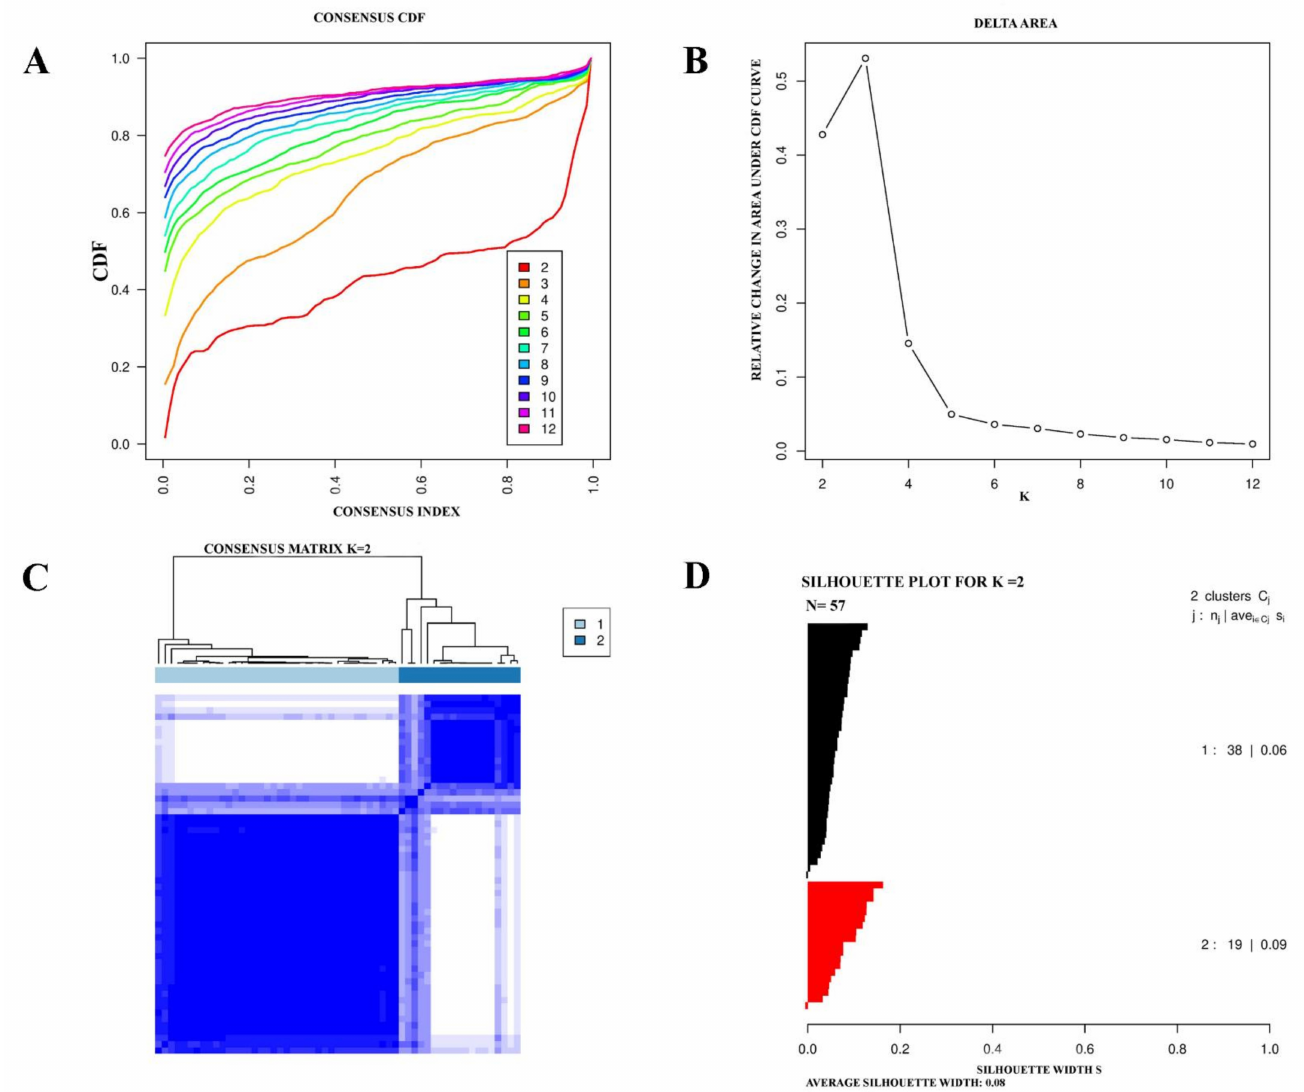
Figure 1. The TCGA cohort of eMPM, represented two molecular subtypes. ( A ) Using an empir- ical cumulative distribution plot, the optimal number of eMPM molecular subtypes was found. ( B ) Comparative increase in the area under the CDF curve along with increasing expected number of molecular subtypes. ( C ) Matrix of Consensus clustering for the two unique eMPM subtypes. ( D ) Silhouette plot of eMPM based on Consensus clustering